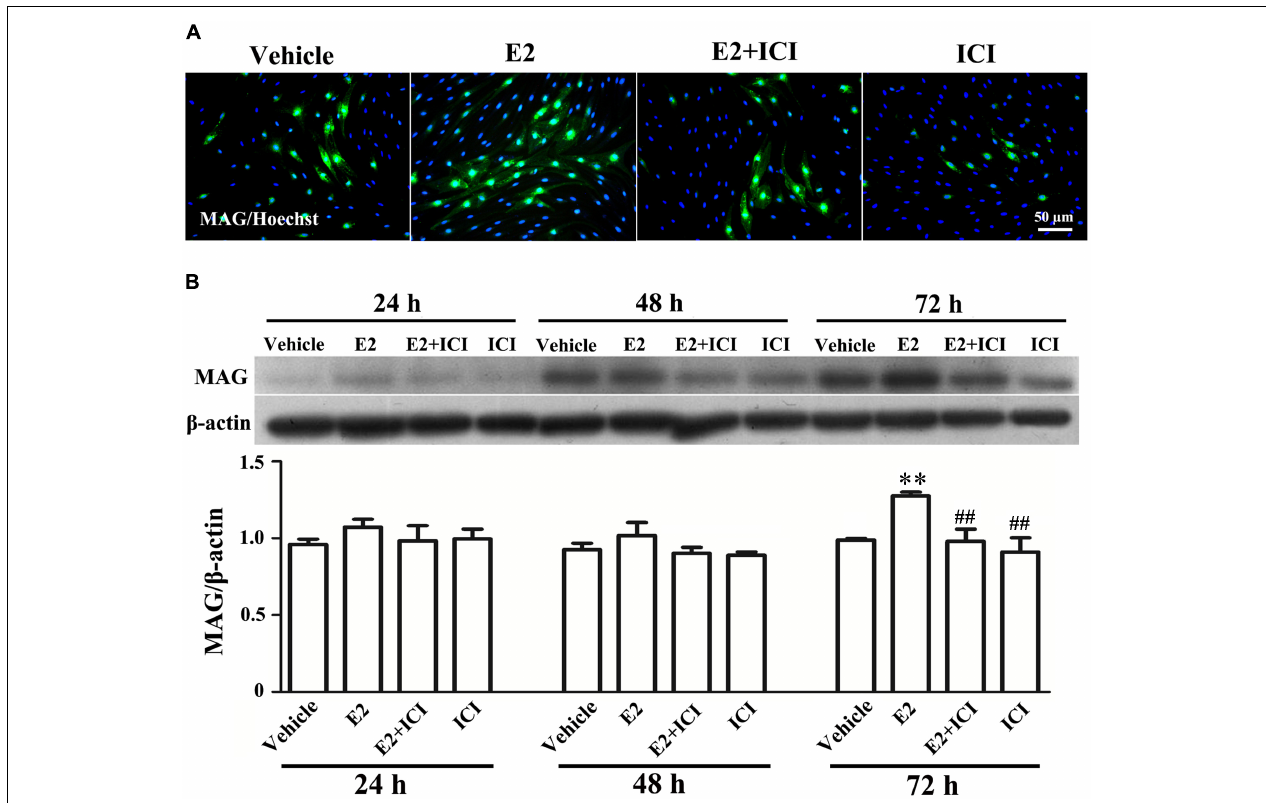
FIGURE 4 | E2 treatment accelerated Schwann cell differentiation via the estrogen receptors (ERs). (A) Immunocytochemistry with anti-MAG (green) displayed the SC differentiation efficacy of the different inducers that were cultured in vehicle or with E2 treatment, or ICI182780 (antagonist of ERs) treatment, or E2 plus ICI182780 treatment. Scale bar, 50 µ m. (B) Western blotting compared the MAG expression in differentiated cells treated with E2, ICI182780, E2 plus ICI182780 for 1, 2, and 3 days, and vehicle as control. Also shown (Upper) are representative Western blot images, in which β -actin served as an internal standard. ∗∗ p < 0.01 versus vehicle, and ## p < 0.05 versus E2. One-way ANOVA, n = 3 cultures per group. All the data are mean ± SEM.